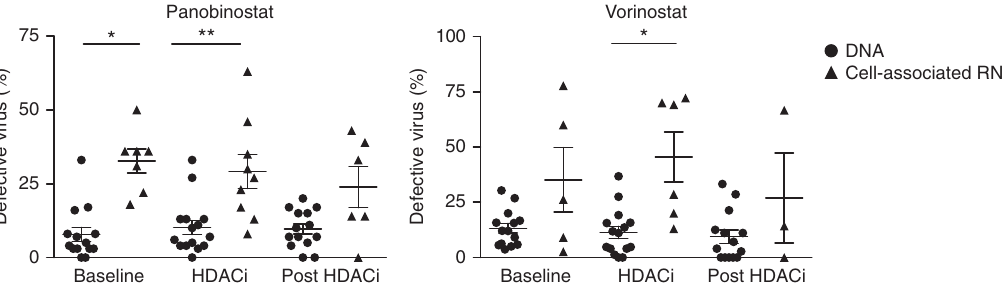
Figure 3 | A significant proportion of cell-associated HIV-1 RNA is defective. The percentage of defective virus detected in CD4 þ Tcells collected from HIV-infected participants on ART before, during and following administration of panobinostat (baseline DNA n ¼ 14, RNA n ¼ 7; on HDACi DNA n ¼ 15, RNA n ¼ 9; post HDACi DNA n ¼ 14, RNA n ¼ 6) or vorinostat (baseline DNA n ¼ 14, RNA n ¼ 5; on HDACi DNA n ¼ 15, RNA n ¼ 6; post HDACi DNA n ¼ 14, RNA n ¼ 3). Each data point represents the group mean, and the error bars represent the s.e.m. * P r 0.05, ** P r 0.01. The Wilcoxon signed rank test was used to generate the P